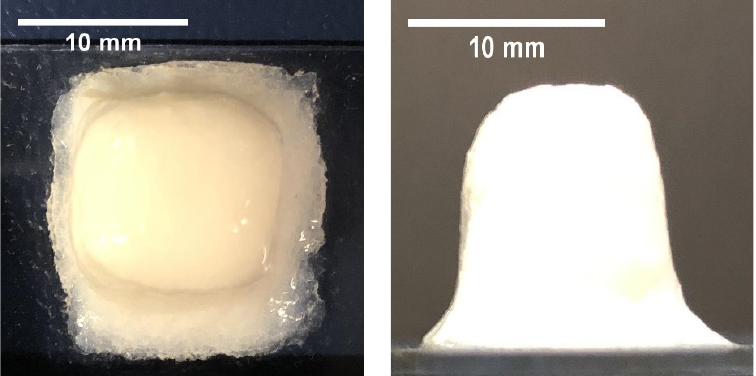
Figure 5. Exemplary result of a spray-printed pillar-like structure (dimensions: 11 mm by 11 mm by 13 mm; 225 layers). Left: top-view. Right: side-view.